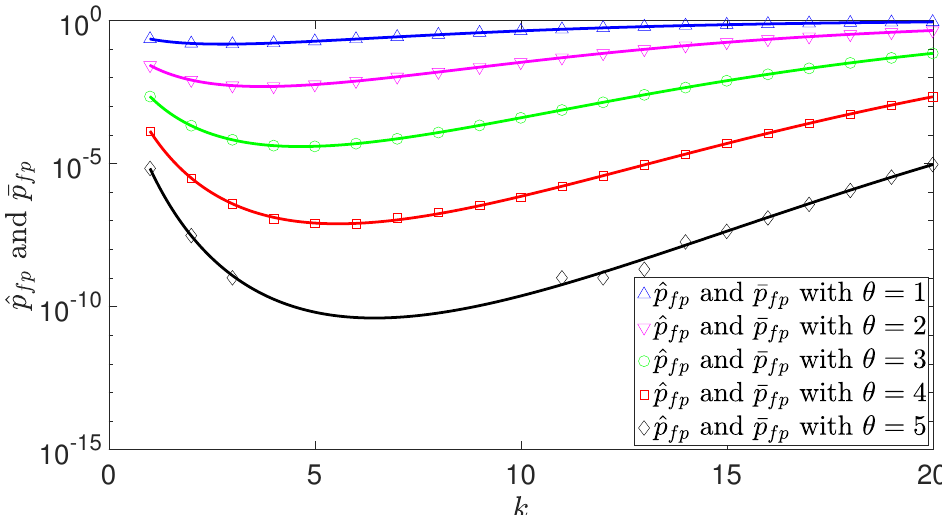
Figure 7. Plot of false positive theoretical values ( ˆ p fp ) and simulation results ( ¯ p fp ) where n = 10,000,000, m = 40,000,000, θ = 1,2,3,4,5, and n q = n vs. k between 1 to